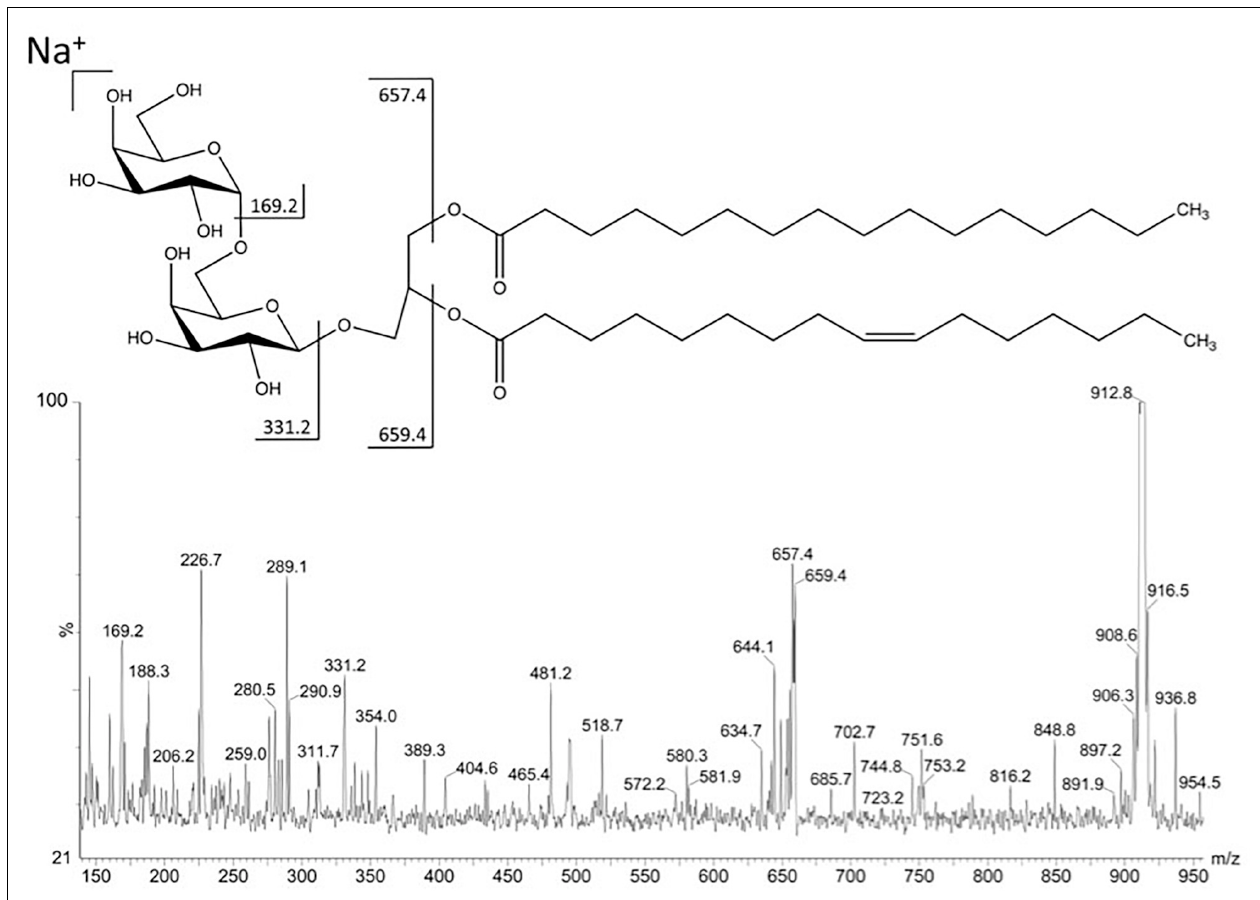
FIGURE 3 | Fragmentation in positive mode of the major ion at m/z 912.8 detected in fraction F4II70a.